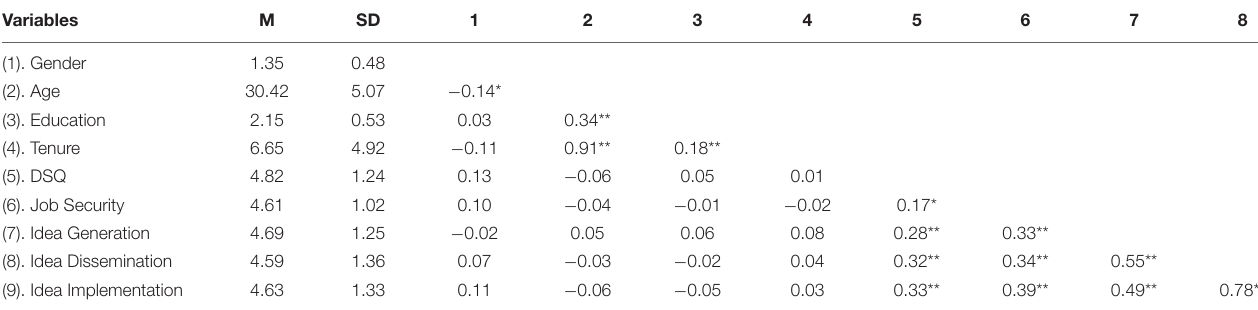
TABLE 2 | All variables’ means, standard deviations, and correlation matrix. Variables